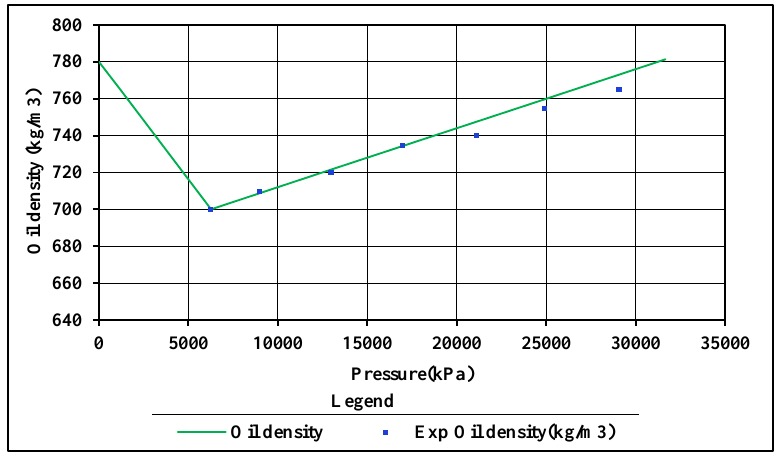
Figure 3—Fitting result of the oil density at the formation temperature.